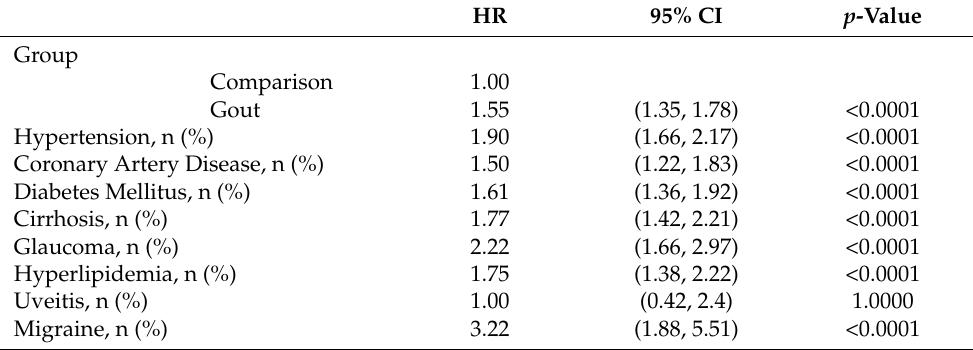
Table 2. Hazard ratio estimated by univariable Cox regression stratified on matched sets.